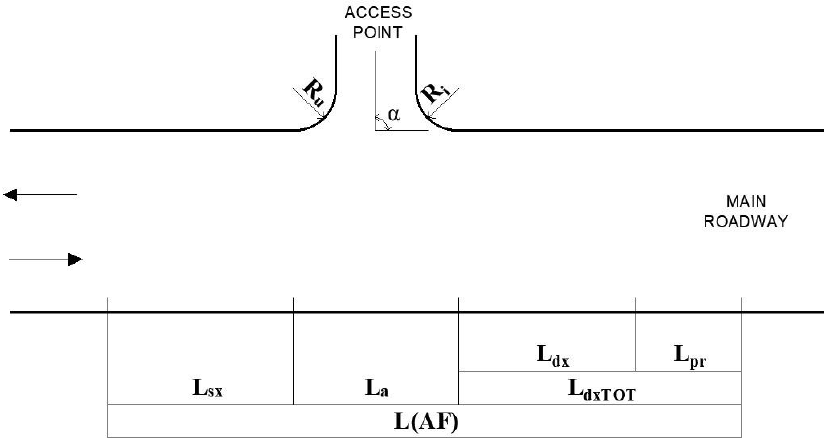
Figure 4. Schematic representation of the geometric elements of an access point and the distances identifying the Functional Area (top view). R i = entry radius, R u = exit radius, α = angle, L a = access width, L sx = downstream functional area (distance), L dxTOT = upstream functional area (distance), L dx = distance related to the deceleration manoeuvre; L pr = distance traveled during the perception-reaction time.